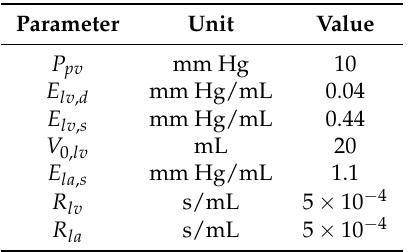
Table 6. Parameters of the heart model with LV DCM.